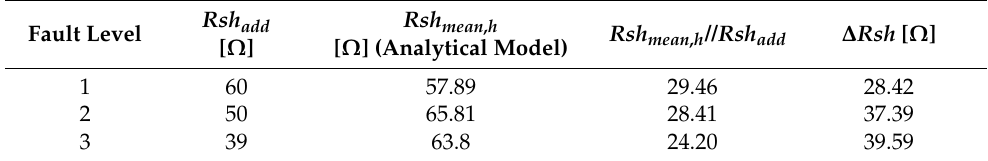
Figure 27. FDD in the case of R sh degradation. ( a ): Measured and estimated shunt resistance values; ( b ): Residuals. Table 18. Three levels of severity for R sh degradation.